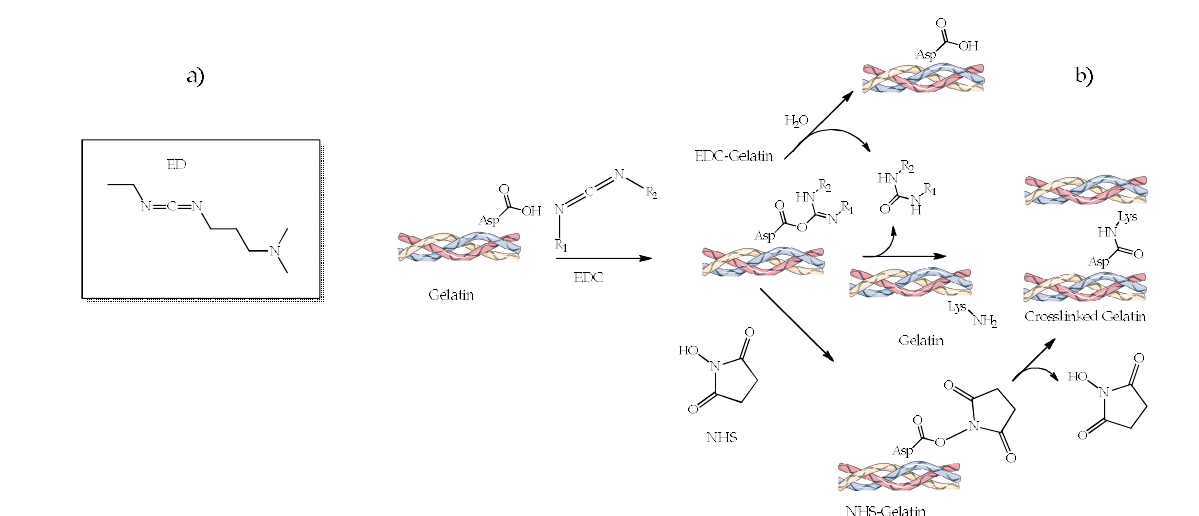
Figure 5. EDC chemical structure ( a ) and schematic representation of the EDC-crosslinking reaction ( b ) with or without NHS.